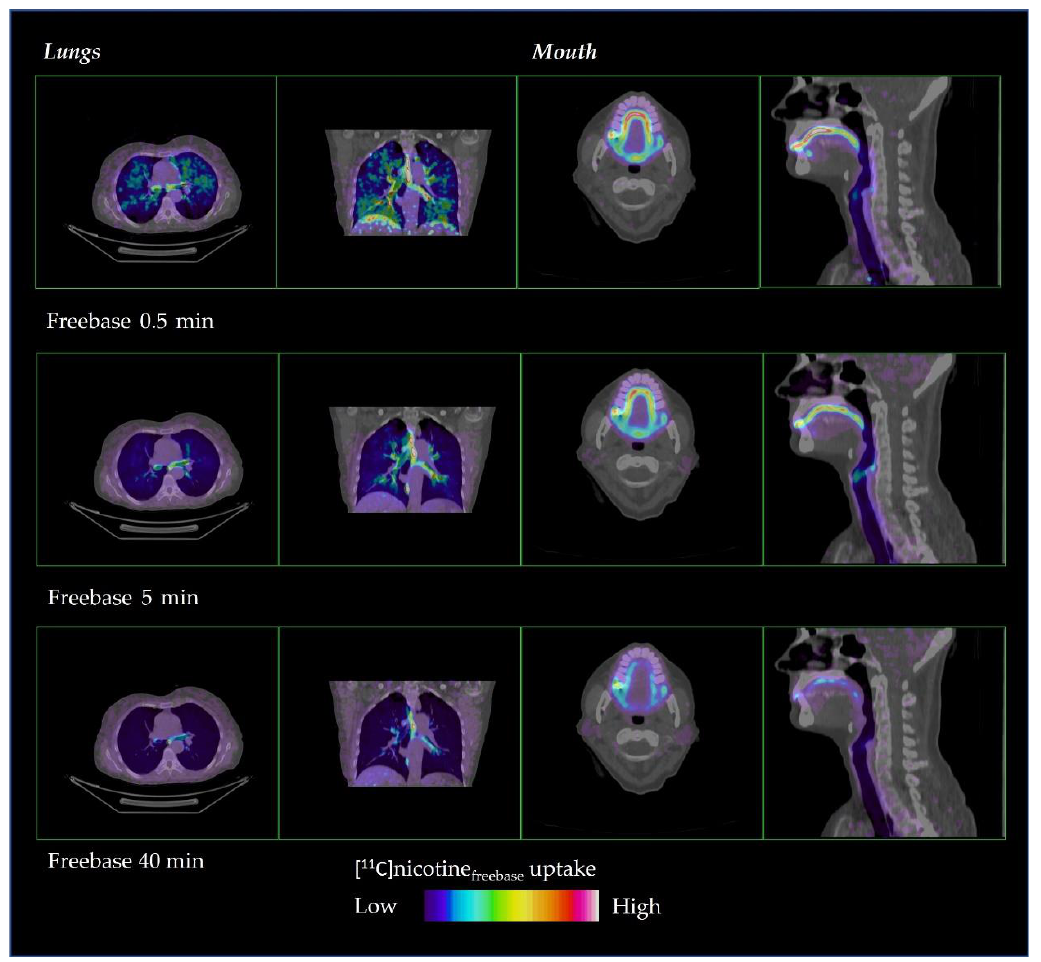
Figure 2. Representative distribution of [ 11 C]nicotine freebase in lungs and mouth at 0.5, 5 and 40 min after inhalation.